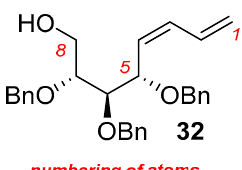
Figure 12. The structure of diene 32.